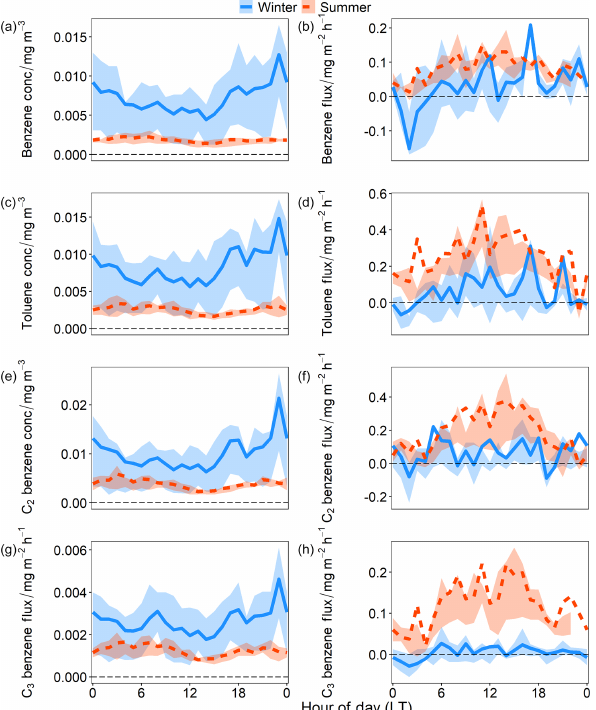
Figure 9. Diurnal profiles for (a) benzene concentration, (b) ben- zene flux, (c) toluene concentration, (d) toluene flux, (e) C 2 - benzene concentration, (f) C 2 -benzene flux, (g) C 3 -benzene con- centration and (h) C 3 -benzene flux measured by PTR-ToF-MS. Blue, solid lines are for measurements taken during the winter cam- paign and the orange, dashed lines are measurements taken during the summer campaign. The shaded areas represent the 25th and 75th percentiles to give an idea of the spread of the data. Only station- ary data have been used, but no u ∗ filtering has been applied when doing the diurnal